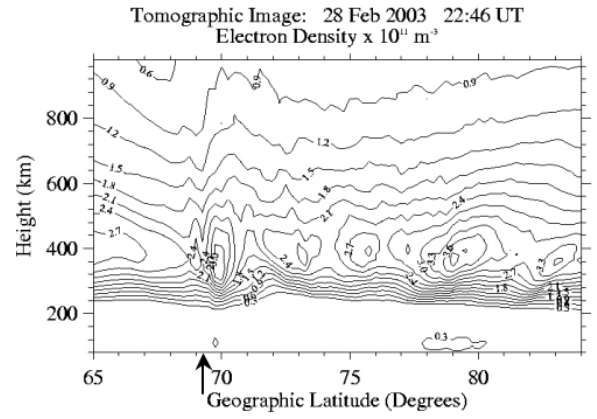
Fig. 11. Electron density tomographic images at 22:46 UT on 28 February 2003 showing that enhanced densities that were associ- ated with the auroral activity extended to latitudes equatorward of Sodankyl¨a. The arrow indicates the latitude of the tristatic A posi-